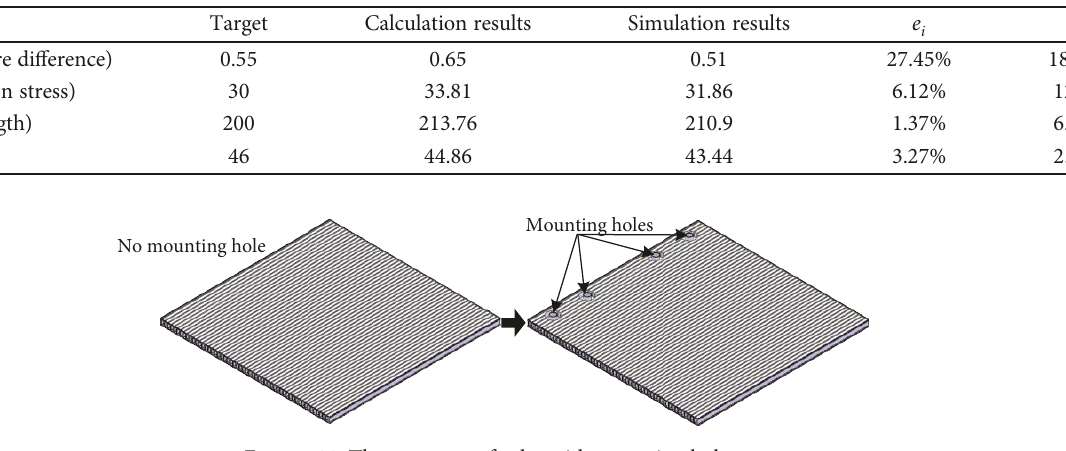
Figure 11: The new type of solar with mounting holes.